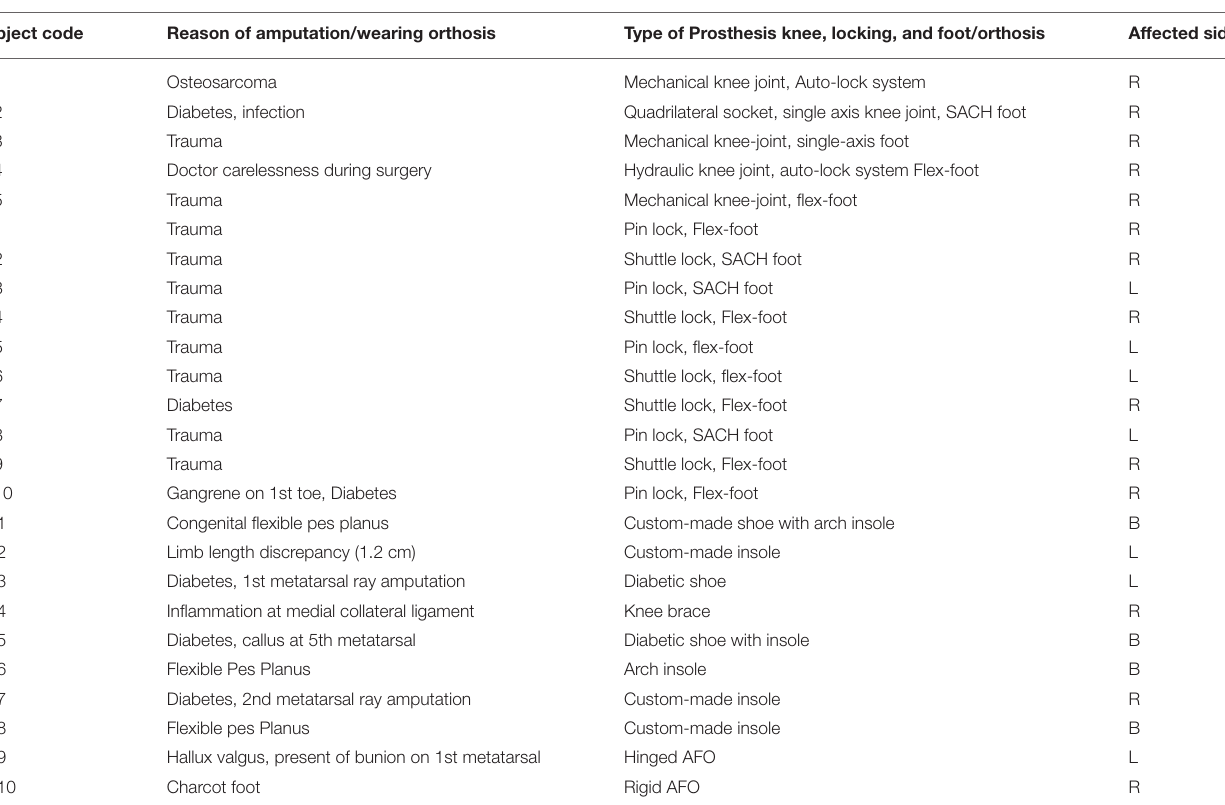
TABLE 2 | Profile data for transfemoral, transtibial and orthosis